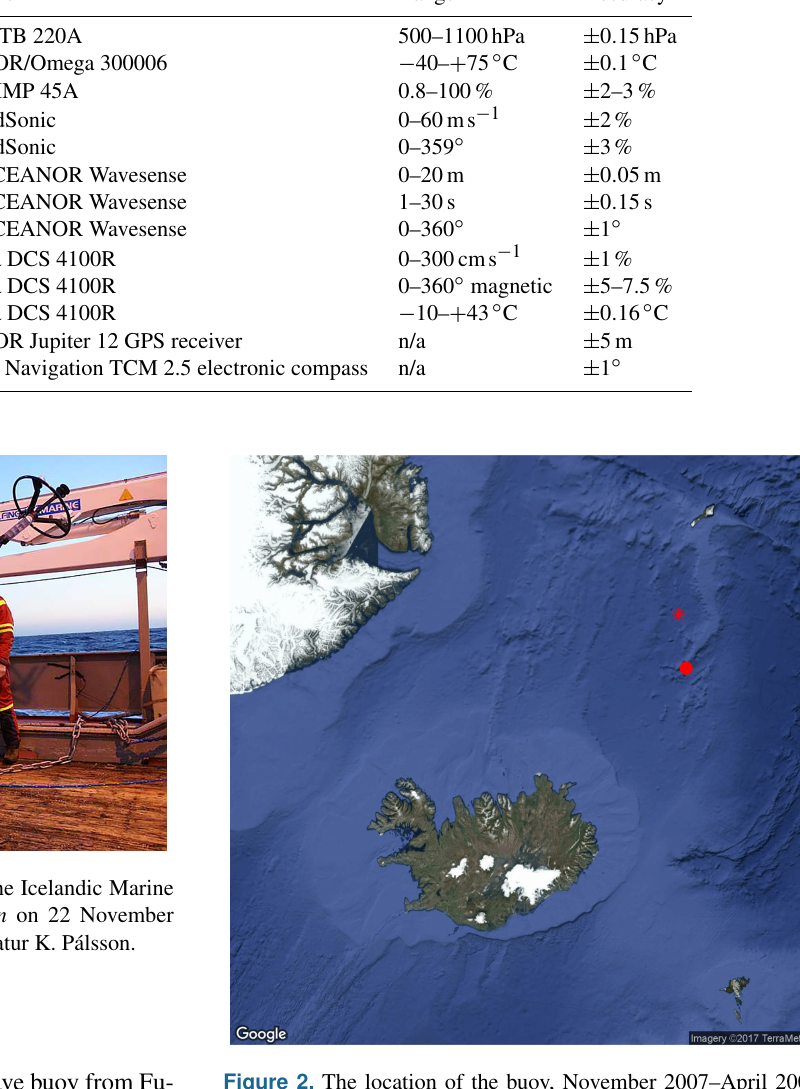
Figure 2. The location of the buoy, November 2007–April 2009. The retrieval location on 21 August 2009 is marked with a